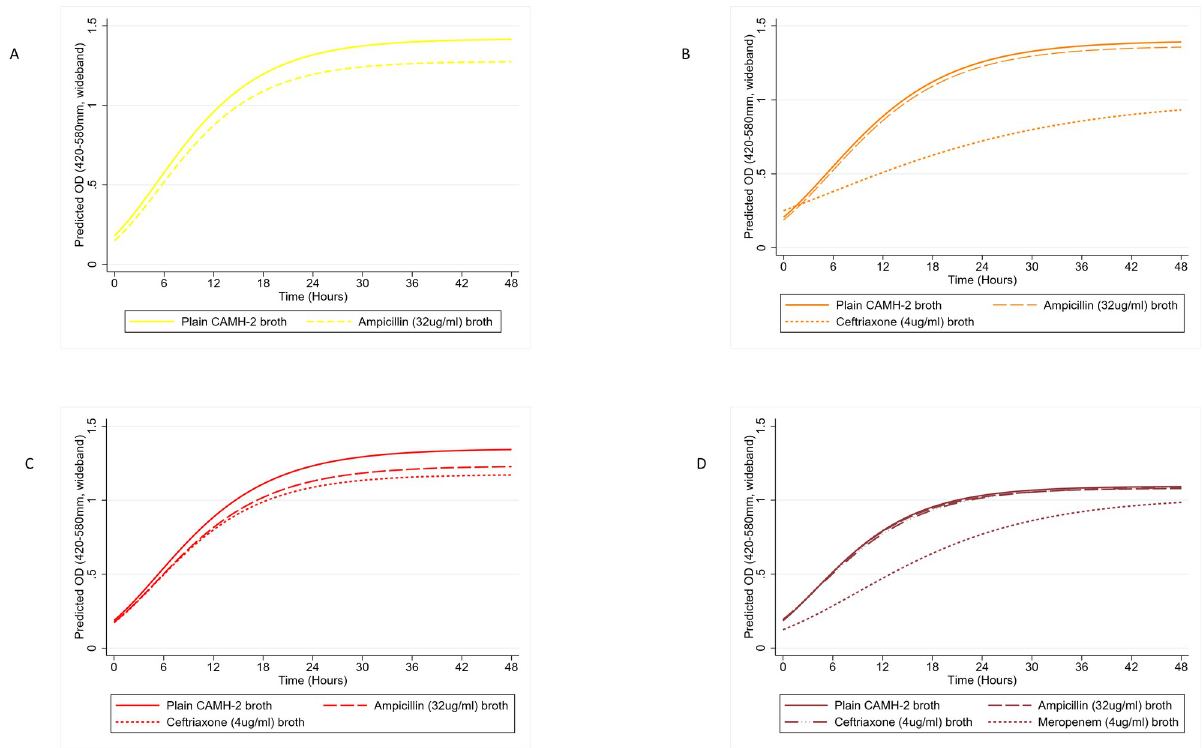
Fig 3. Growth curves of bla -gene positive E . coli resistance gene groups grown in beta-lactam antimicrobial broth, estimated with a 3-parameter Gompertz model. (a) bla TEM-1 gene encoding strains in plain CAMH-2 broth and ampicillin (32 μ g/mL) broth, (b) bla CMY-2 gene encoding strains in plain CAMH-2 broth, ampicillin (32 μ g/mL) and ceftriaxone (4 μ g/mL) broths, (c) bla CTX-M- � gene encoding strains in plain CAMH-2 broth, ampicillin (32 μ g/mL) and ceftriaxone (4 μ g/mL) broths, (d) bla KPC/IMP/NDM encoding strains in plain CAMH-2 broth, ampicillin (32 μ g/mL), ceftriaxone (4 μ g/mL) and meropenem (4 μ g/mL) broths. CAMH-2 (Cation-adjusted Mueller Hinton II).